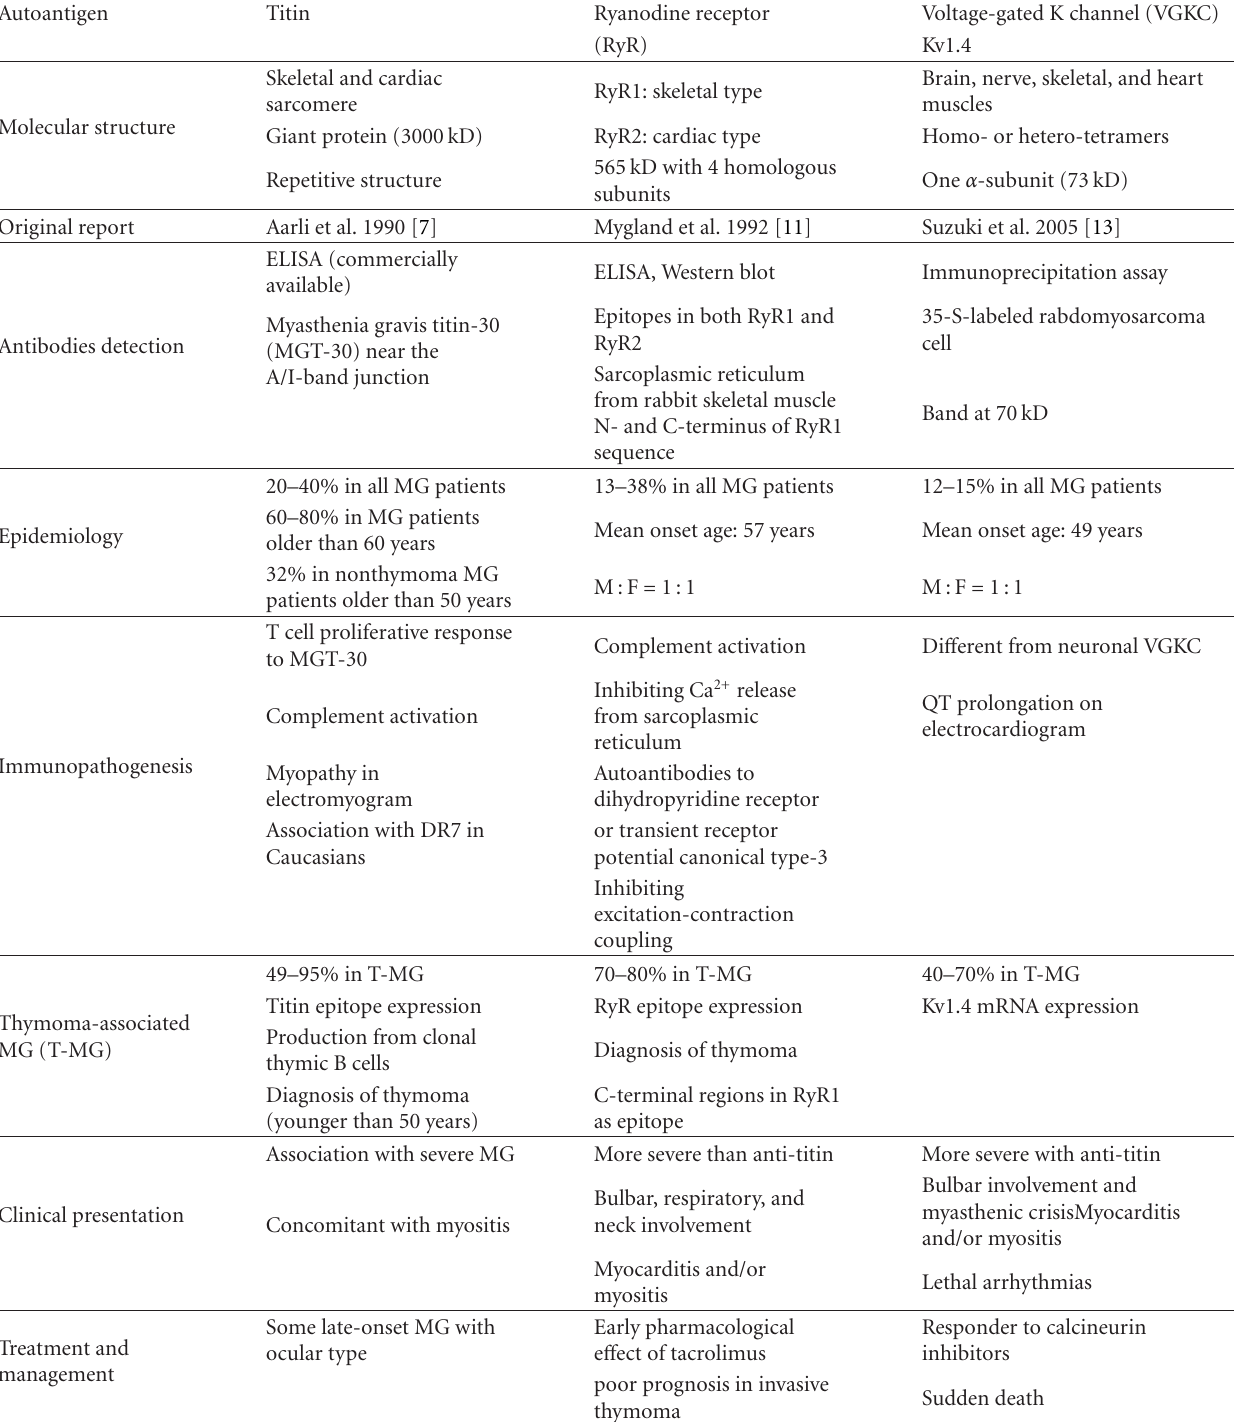
Table 1: Three types of striational antibodies in myasthenia gravis